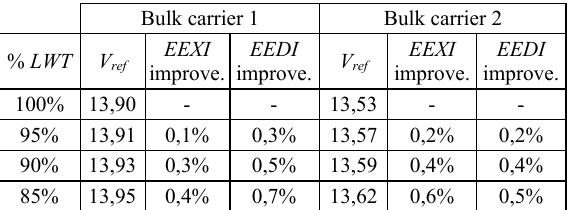
Figure 6. characteristic sections at midship, center line, and water line (dashed line – bulk carrier 1, solid line – bulk carrier 2) Table 6. EEXI / EEDI improvement assessment Table 8. Brake power reduction – bulk carrier 2